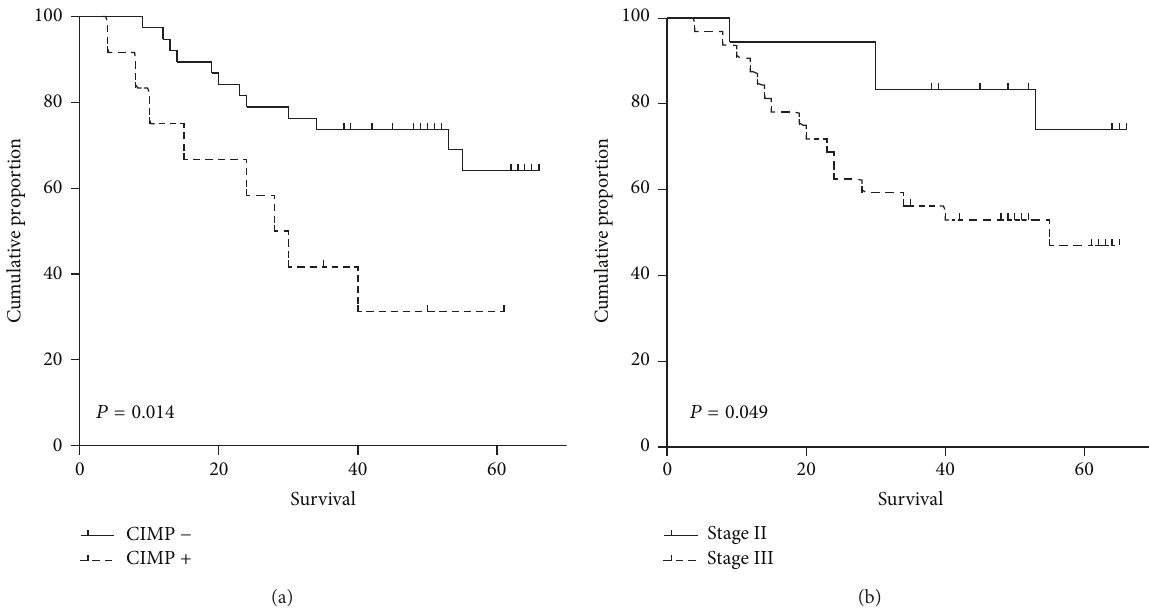
Figure 1: Disease-free survival analysis according to stage and CIMP status. Patients with CIMP positive tumors had a marginally significant poor DFS than those with CIMP negative tumors with 𝑃 value =0.014 (a). Patients with stage II disease showed better DFS than those with stage III disease with 𝑃 value =0.049 (b). DFS: disease-free survival, CIMP: CpG island methylator